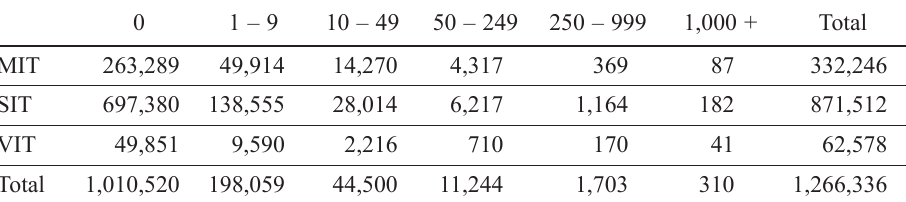
Table 3. Sector map for business units in the Czech Republic,